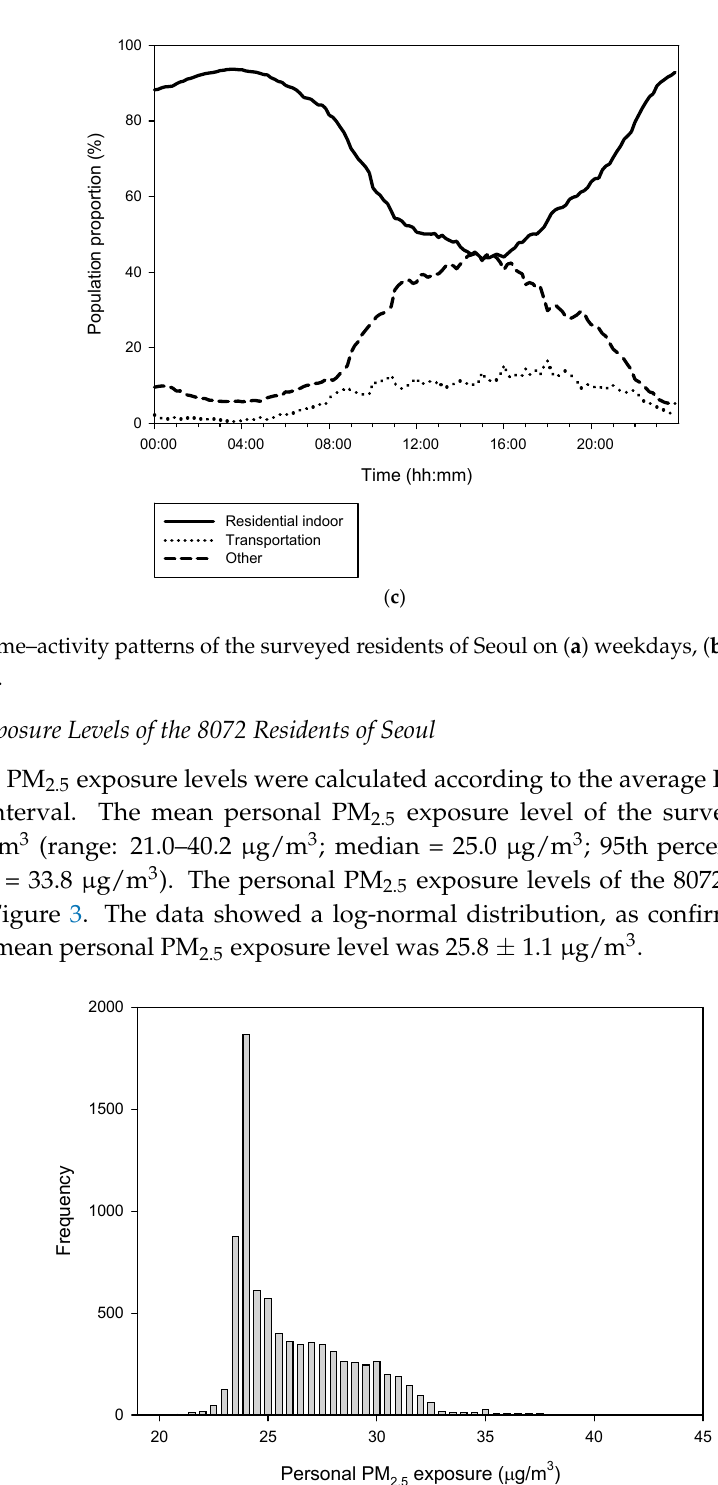
Figure 3. Daily personal PM 2.5 exposure levels ( μ g/m 3 ) of 8072 residents of Seoul.